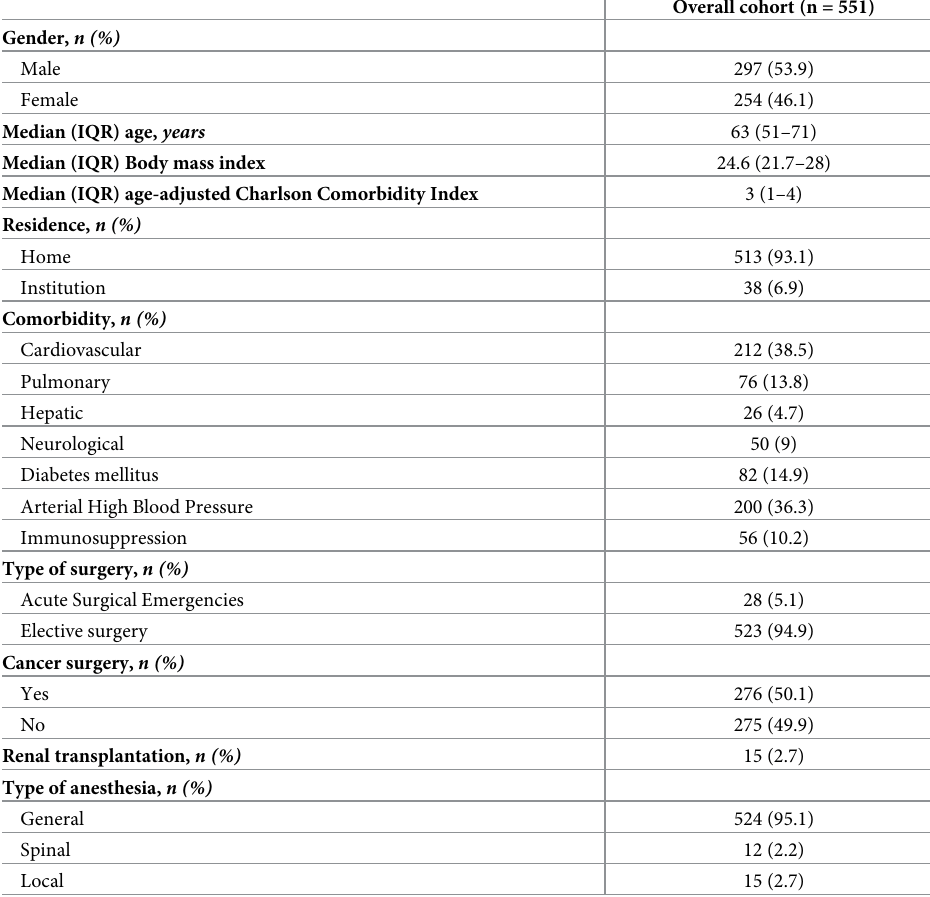
Table 1. Baseline characteristics upon